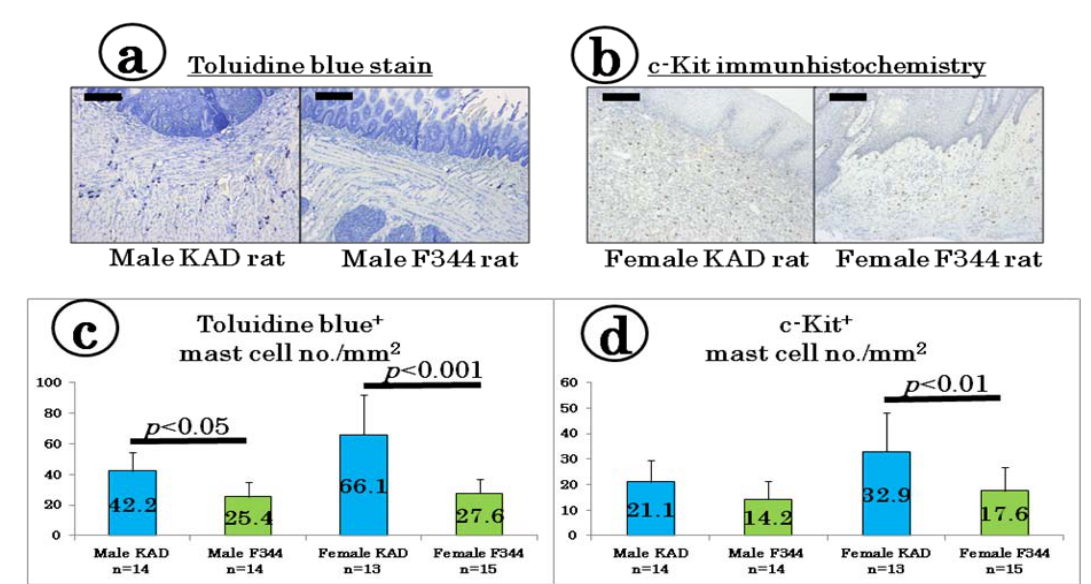
Figure 4. Presence of tongue mast cells determined using ( a ) toluidine blue staining and ( b ) c-Kit immunohistochemistry. Number of mast cells detected using ( c ) toluidine blue stain and ( d ) c-Kit immunohistochemistry. The values are presented as the mean ± SD. The bars in ( a ) and ( b ) are 200 µ m.